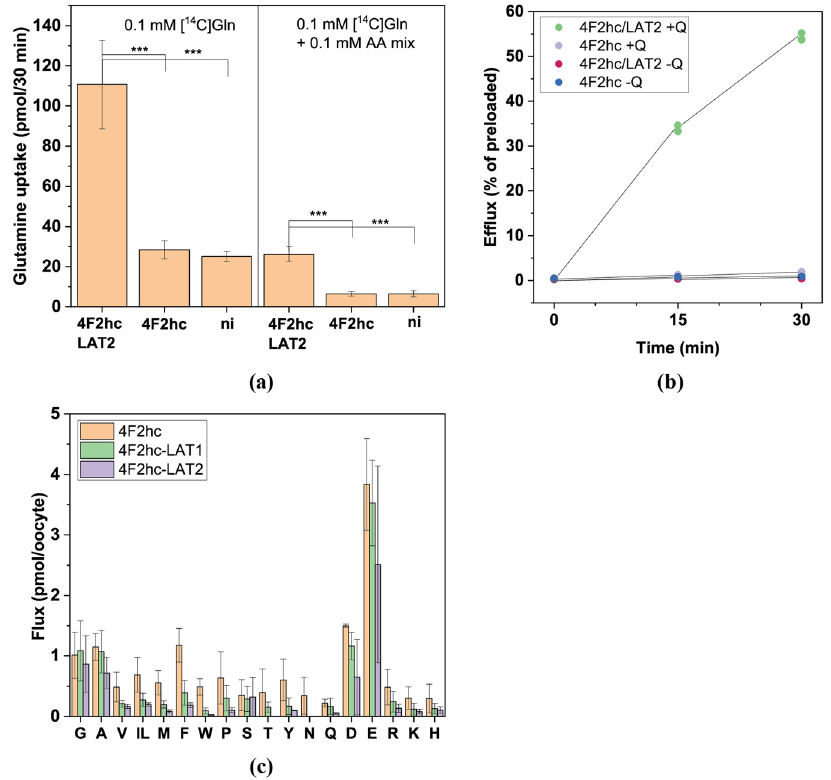
Figure 4. Analysis of asymmetry and uniport activity of LAT1 and LAT2. ( a ) Uptake of 0.1